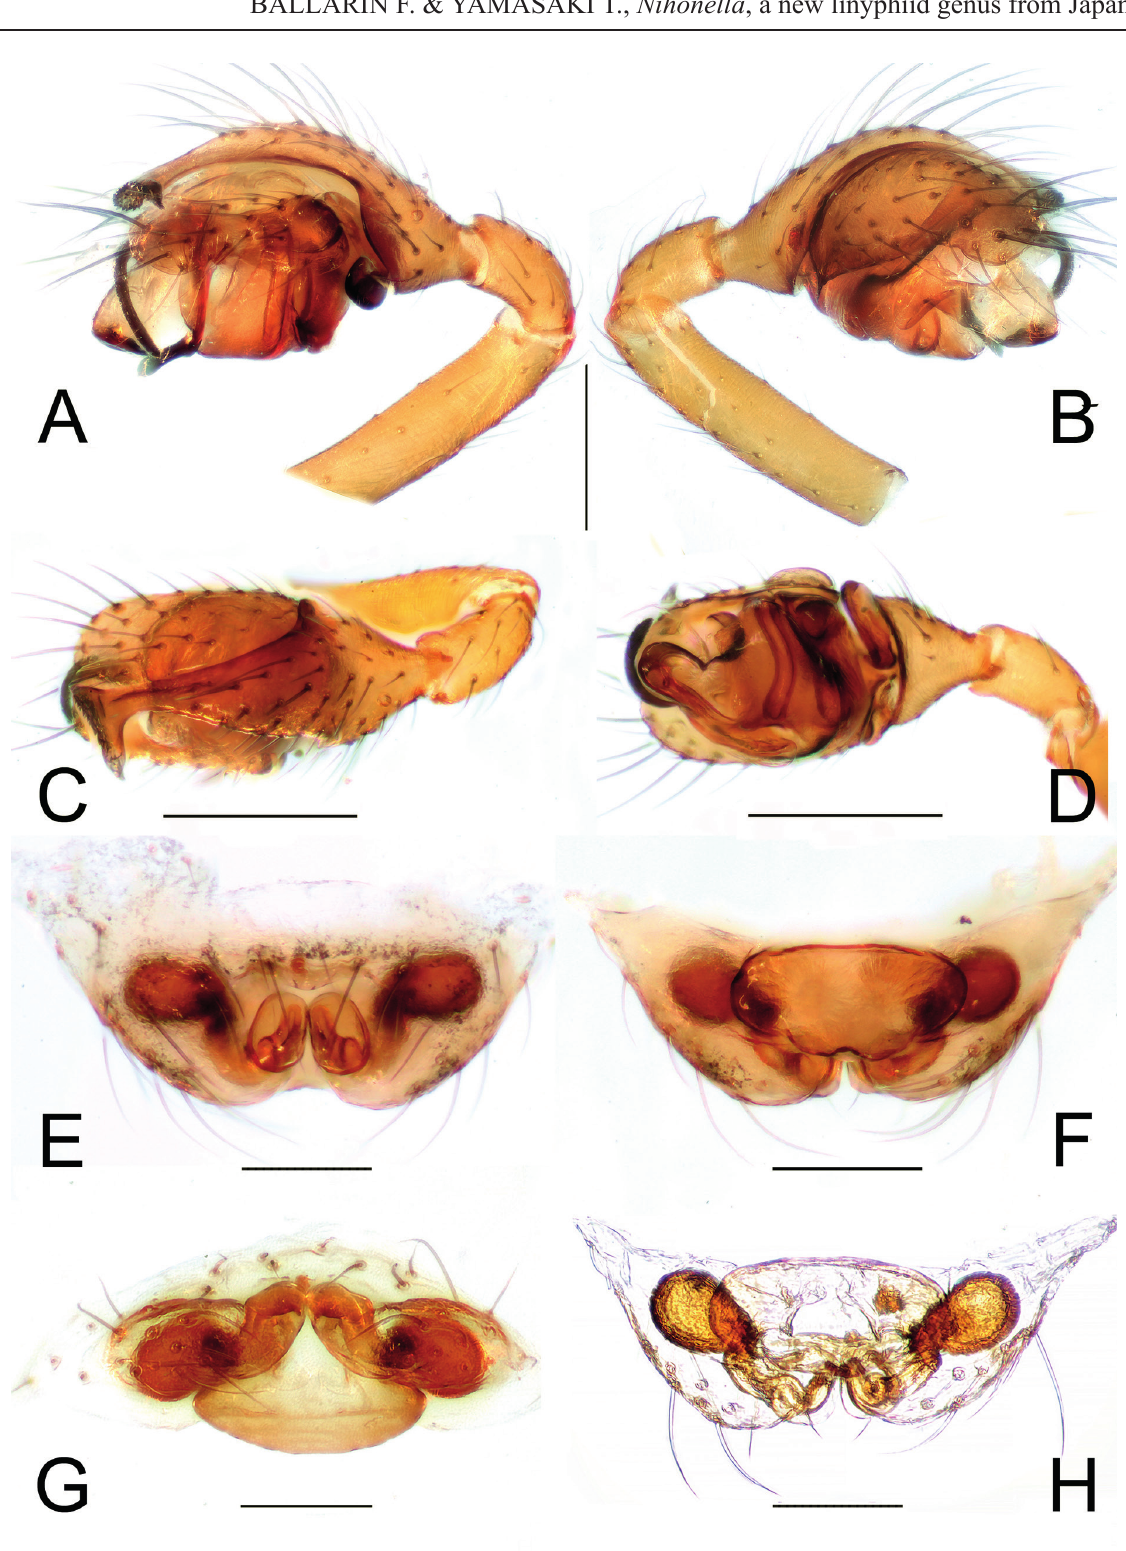
Fig. 2. Genitalia of Nihonella chika gen. et. sp. nov. A . ♂, holotype (NSMT-Ar 20909), palp, retrolateral view. B . Ditto, prolateral view. C . Ditto, dorsal view. D . Ditto, ventral view. E . ♀, paratype (NSMT- Ar 20910), epigyne, ventral view. F . Ditto, dorsal view. G . Ditto, posterior view. H . Ditto, vulva after being cleared, ventral view. Scale bars: A–D = 0.2 mm; E–H = 0.1